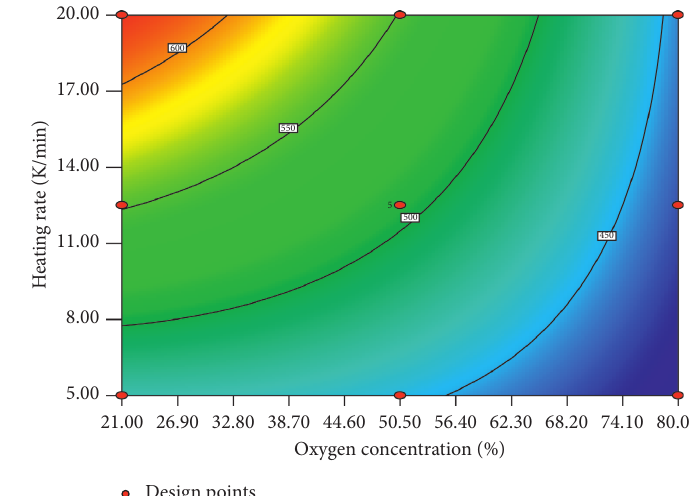
Figure 6: Response surface of the relationship between burnout temperature and oxygen concentration and heating rate.